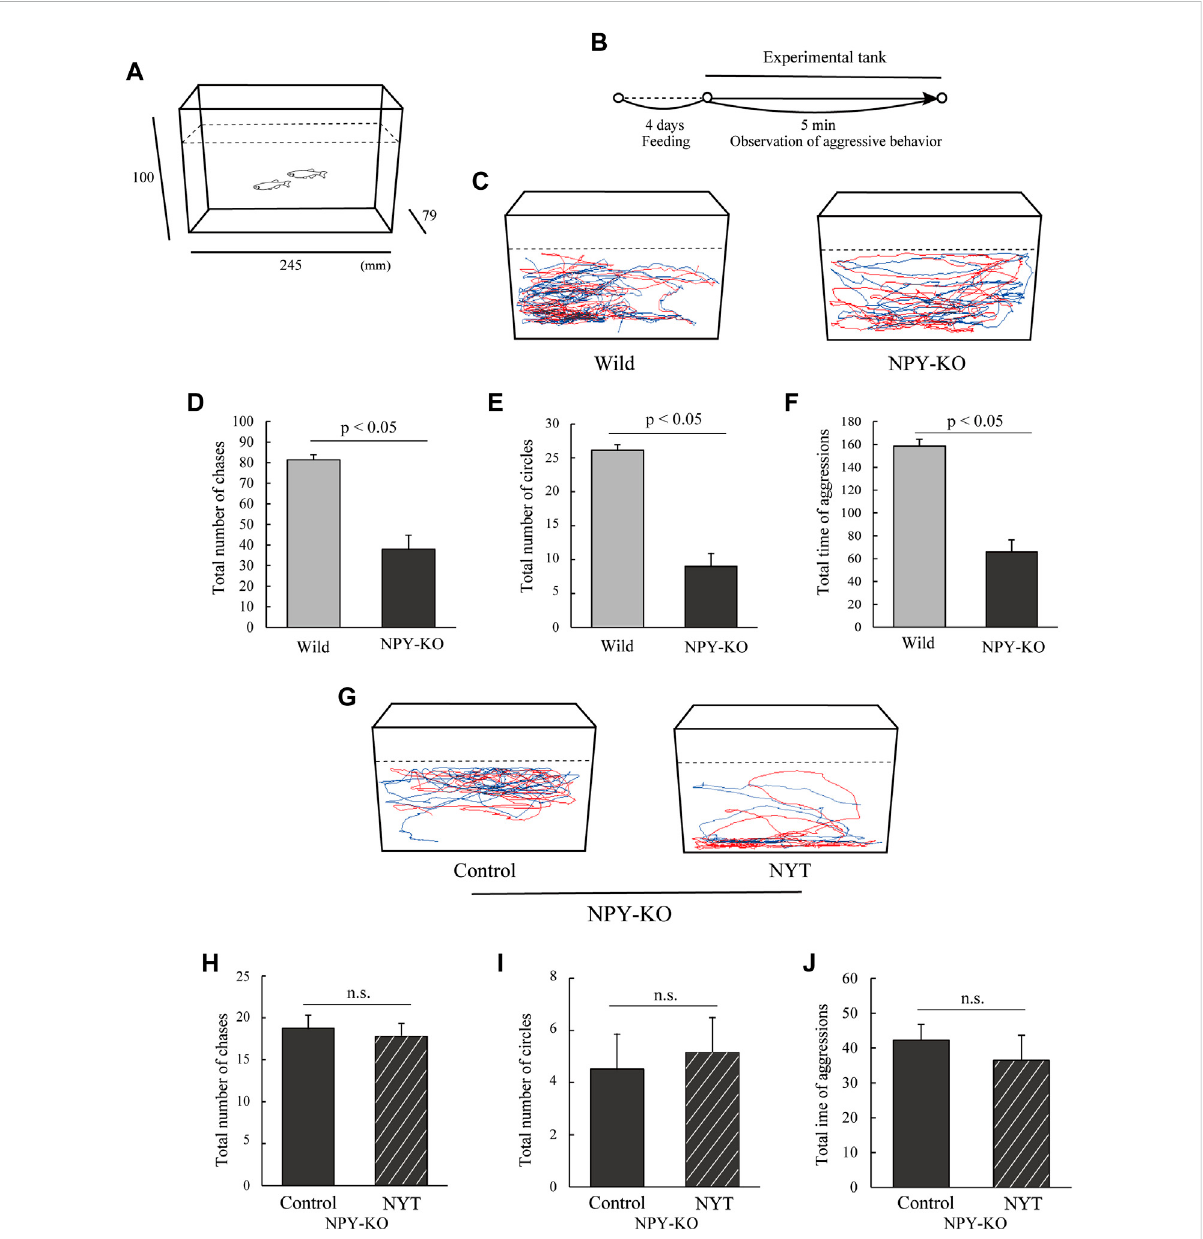
Effect of NYT on aggressive behavior in NPY-KO zebra fi sh. Wild and NPY-KO zebra fi sh were fed either control or NYT twice a day for 4 days. Two unfamiliar male zebra fi sh were set in an aquarium, and their aggressive behavior was analyzed. (A) Test apparatus. (B) Experimental scheme for behavioral evaluation. (C) Tracking ofwild(left) andNPY-KOzebra fi sh (right)swimmingbehavior. (D) Total number ofchases intheWT andNPY-KO zebra fi sh. (E) Total number of circles in the WT and NPY-KO zebra fi sh. Wild, n = 6; NPY-KO, n = 7. (F) Total time of aggression in wild and NPY- KO zebra fi sh. (G) Tracking of control (left) and NYT-fed (right) swimming behavior in NPY-KO zebra fi sh. (H) Total number of chases in control and NYT-fed NPY-KO zebra fi sh. (I) Total number of circles in control and NYT-fed NPY-KO zebra fi sh. (J) Total aggression time in control and NYT-fed NPY-KO zebra fi sh. n = 6. n.s., not signi fi cant. Results are shown as mean ± standard error of the